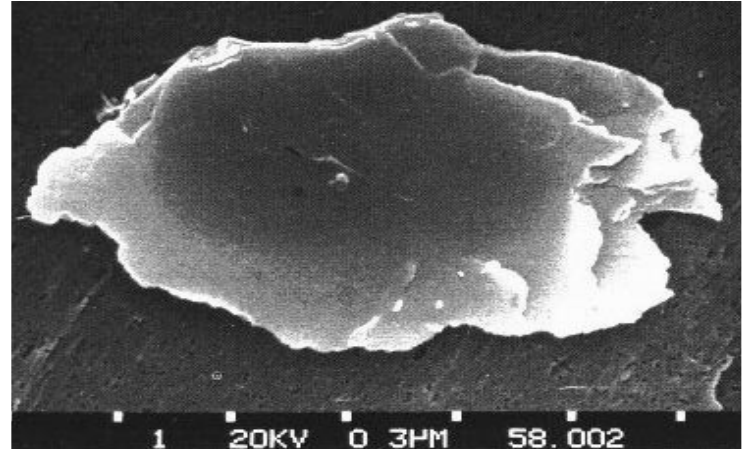
Figura 3. Fotografia obtida por microscopia eletrônica de varredura, mostrando o intemperismo da biotita na fração silte fino no horizonte 2Btn do